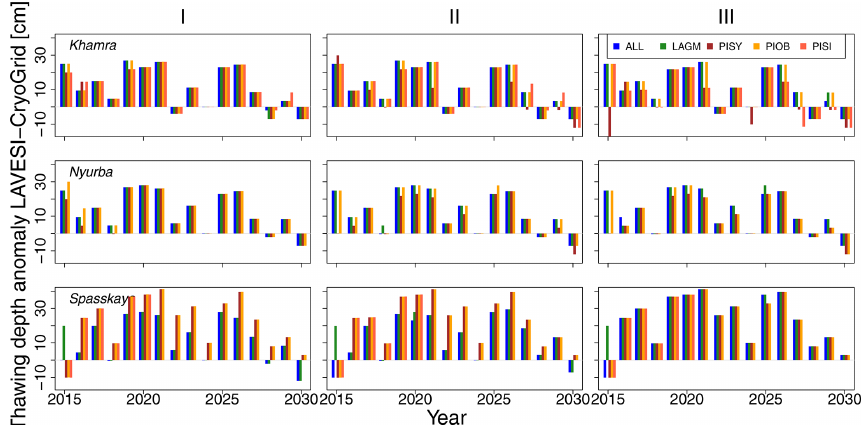
Figure 3. Thawing depth anomaly in the coupled simulation model for all focus areas (rows) and areas within the simulation areas (columns: I, II, and III) for year steps 2015–2030. LAGM: Larix gmelinii ; PIOB: Picea obovata ; PISI: Pinus sibirica ; PISY: Pinus sylvestris